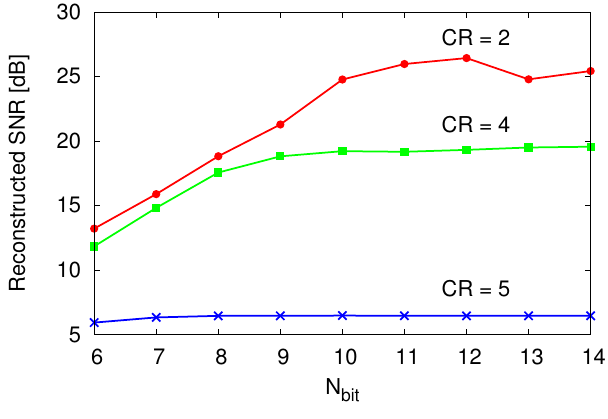
Figure 6. Reconstructed SNR vs. bit resolution of the TDC.